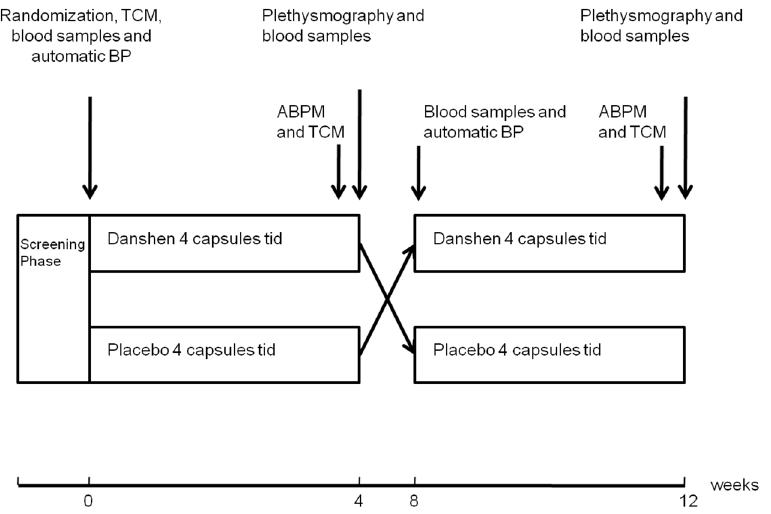
Fig 2. Graphic presentation of the study protocol. Four weeks treatment with Danshen and placebo in a crossover design with at least four weeks of washout (represented in the figure as the period between week 4 and week 8). BP = blood pressure. ABPM = 24-h Ambulatory Blood Pressure Monitoring. TCM = traditional Chinese Medicine